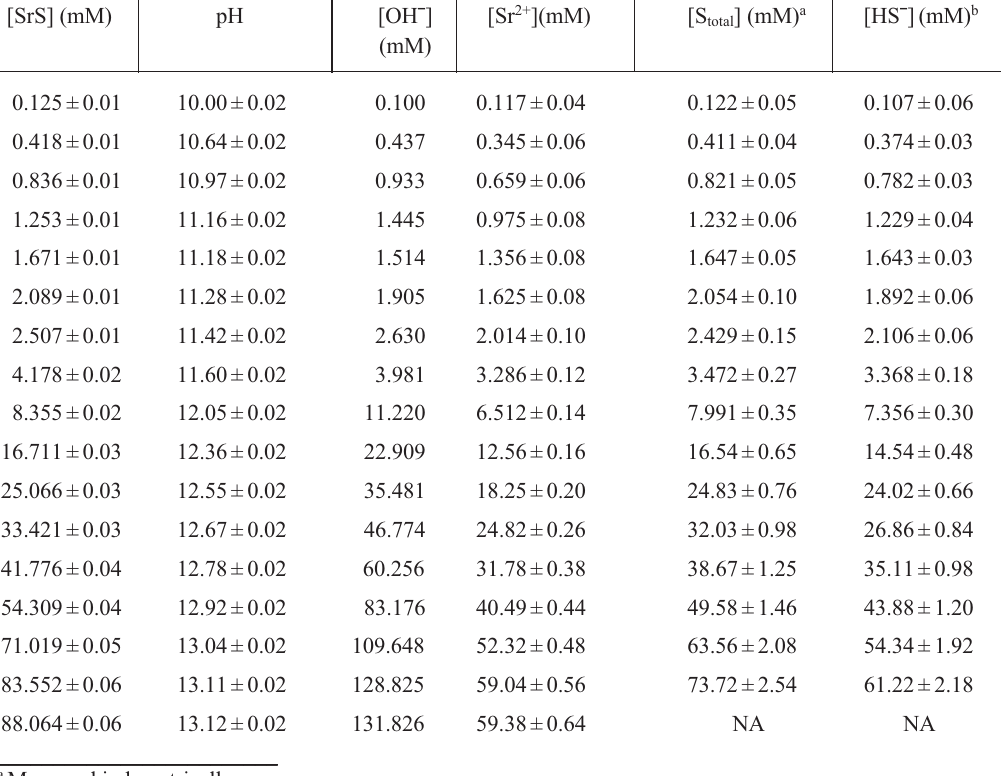
Table 2. Experimentally measured values of pH, concentrations of ions ([Sr 2+ ] , [OHˉ]) and all sulphur forms (S total , including [HSˉ]) in 0.125−88.064 mM [SrS] aqueous solutions